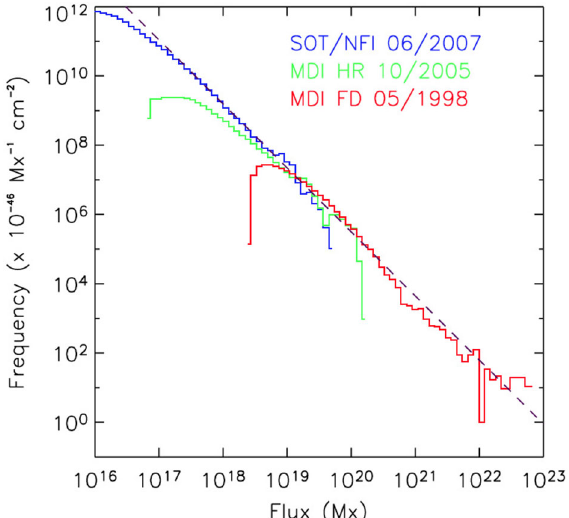
Fig.13 DistributionoflongitudinalmagneticfluxesobservedinHinode/NFImagnetogramsofthequietSun (bluecurve)andSOHO/MDIhighresolutionandfulldiskmagnetograms(greenandredlines,respectively). Image reproduced with permission from Parnell et al. (2009), copyright by